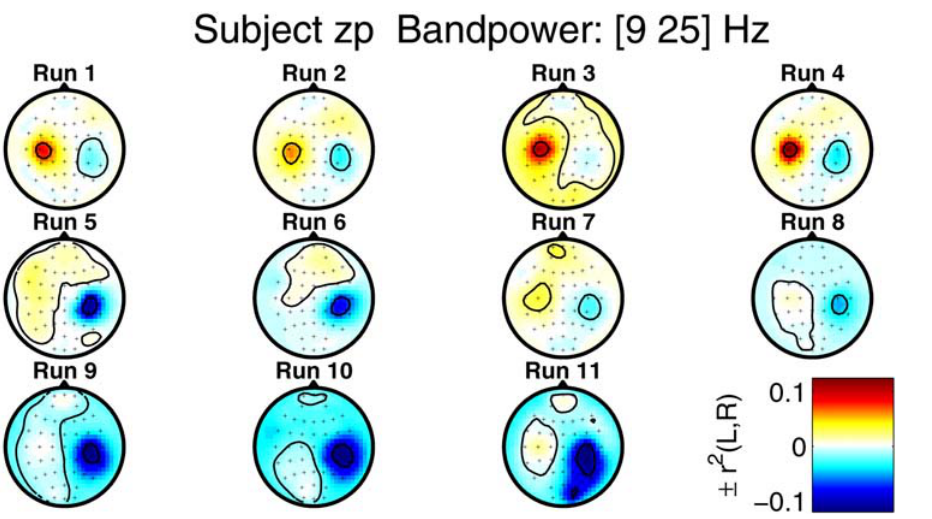
Figure 10. For each feedback run of the session, this figure shows the scalp topographies of class discriminability of band power features for subject zp . After bandpass filtering to the frequency band of 10–25 Hz, the log-bandpower was calculated for each electrode in the window 500–3000 ms after the presentation of the stimulus. Finally, signed r 2 -values were calculated as a measure of class discriminability.